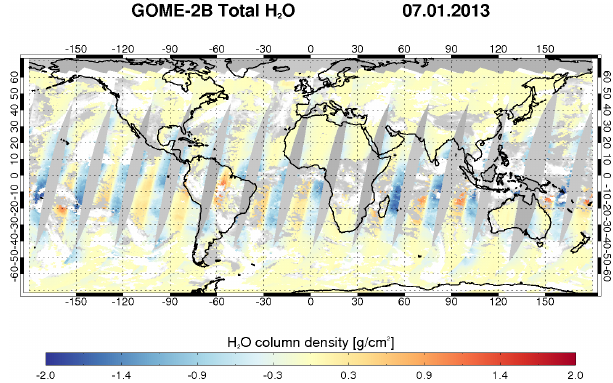
Figure 3. Difference between H 2 O total columns derived from GOME-2B measurements for the 7 January 2013 using the SAD correction and without the SAD